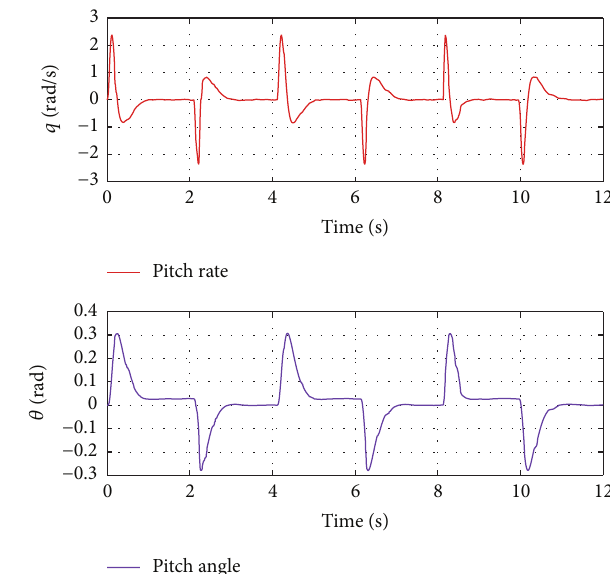
Figure 8: The performance of pitch rate and pitch angle.